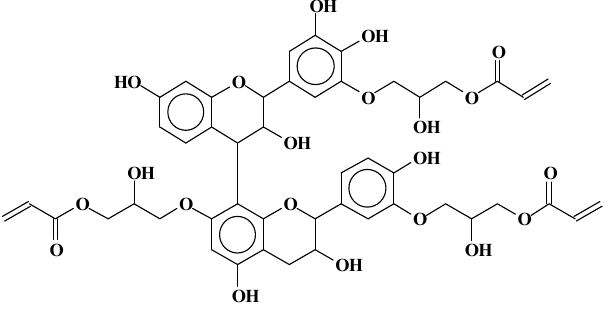
Scheme 8. Chemical structure describing the 976 Da MALDI peak.